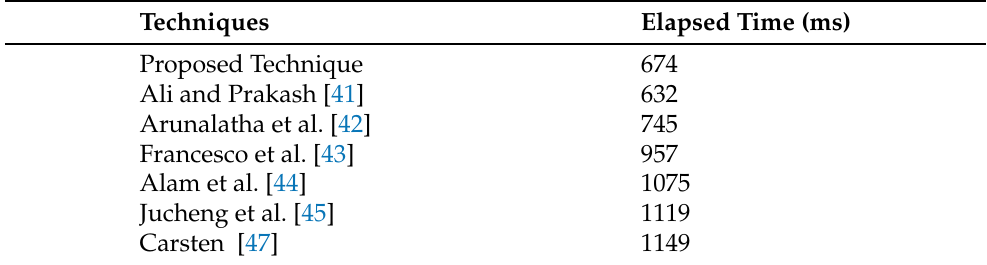
Table 2. Average time taken comparison of various closely related